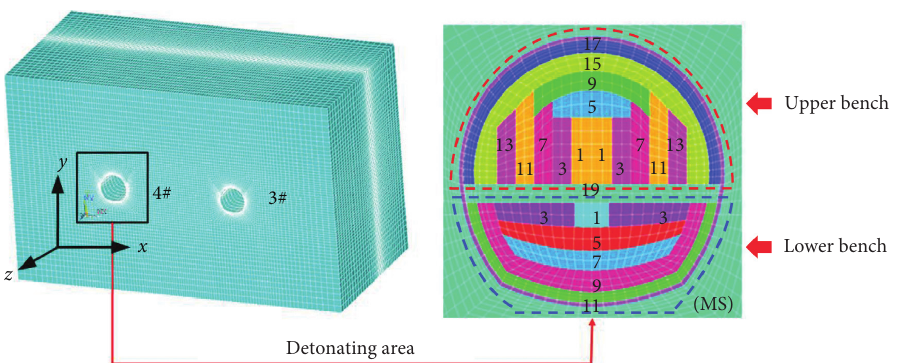
Figure 8: Calculation